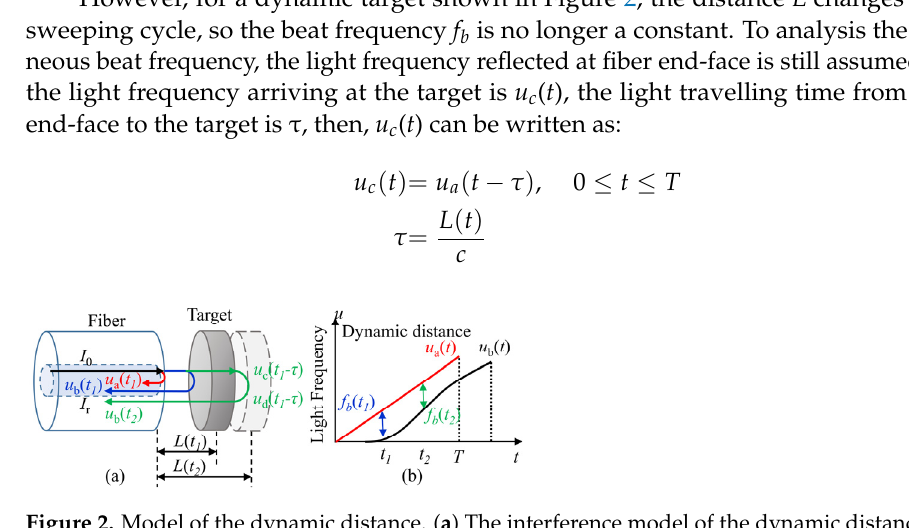
Figure 2. Model of the dynamic distance. ( a ) The interference model of the dynamic distance, a and b are the position out and in the fiber end-face, c and d are the position at the target, t 1 and t 2 are the different moments when the target is moving; ( b ) the beat frequency of the dynamic distance during one sweeping